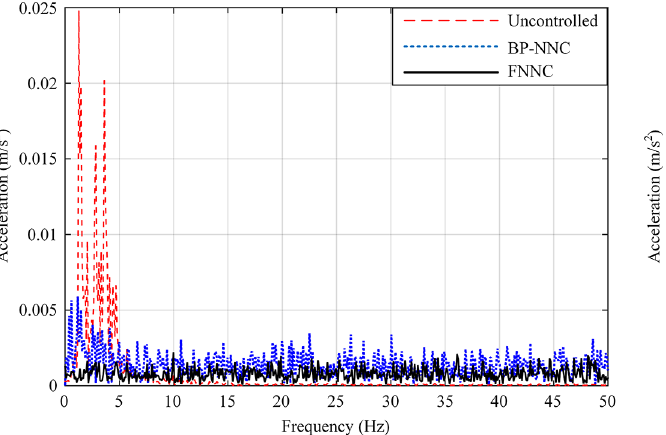
Fig. 22. Frequency-domain response of horizontal vibration acceleration of the elevator car with no load.